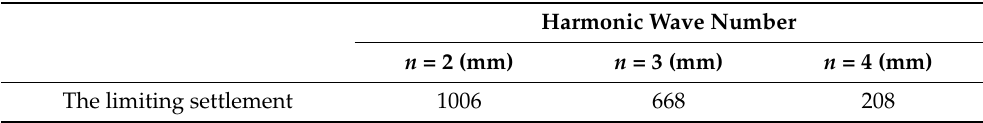
Table 4. The settlement loads for three harmonic